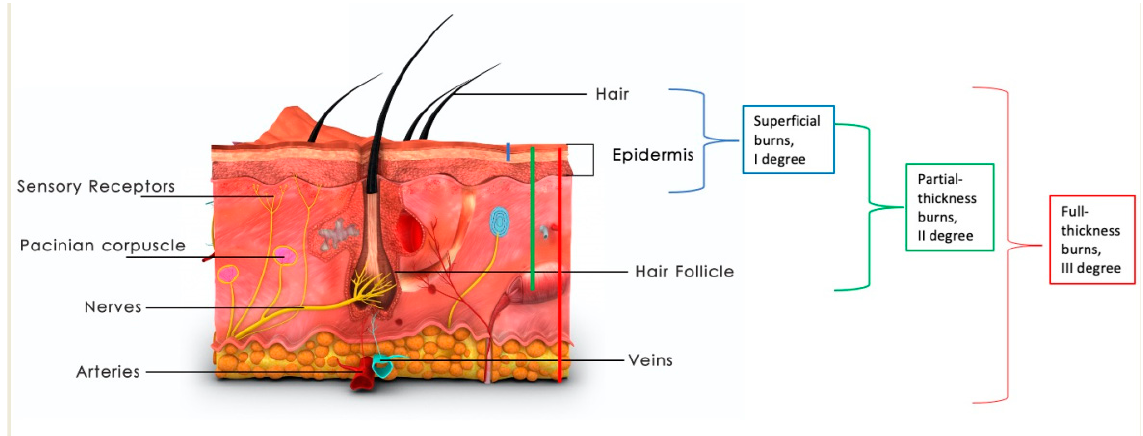
Figure 1. depth of thermal burn. Images purchased under the Adobe Stock License. Figure 1. Depth of thermal burn. Images purchased under the Adobe Stock